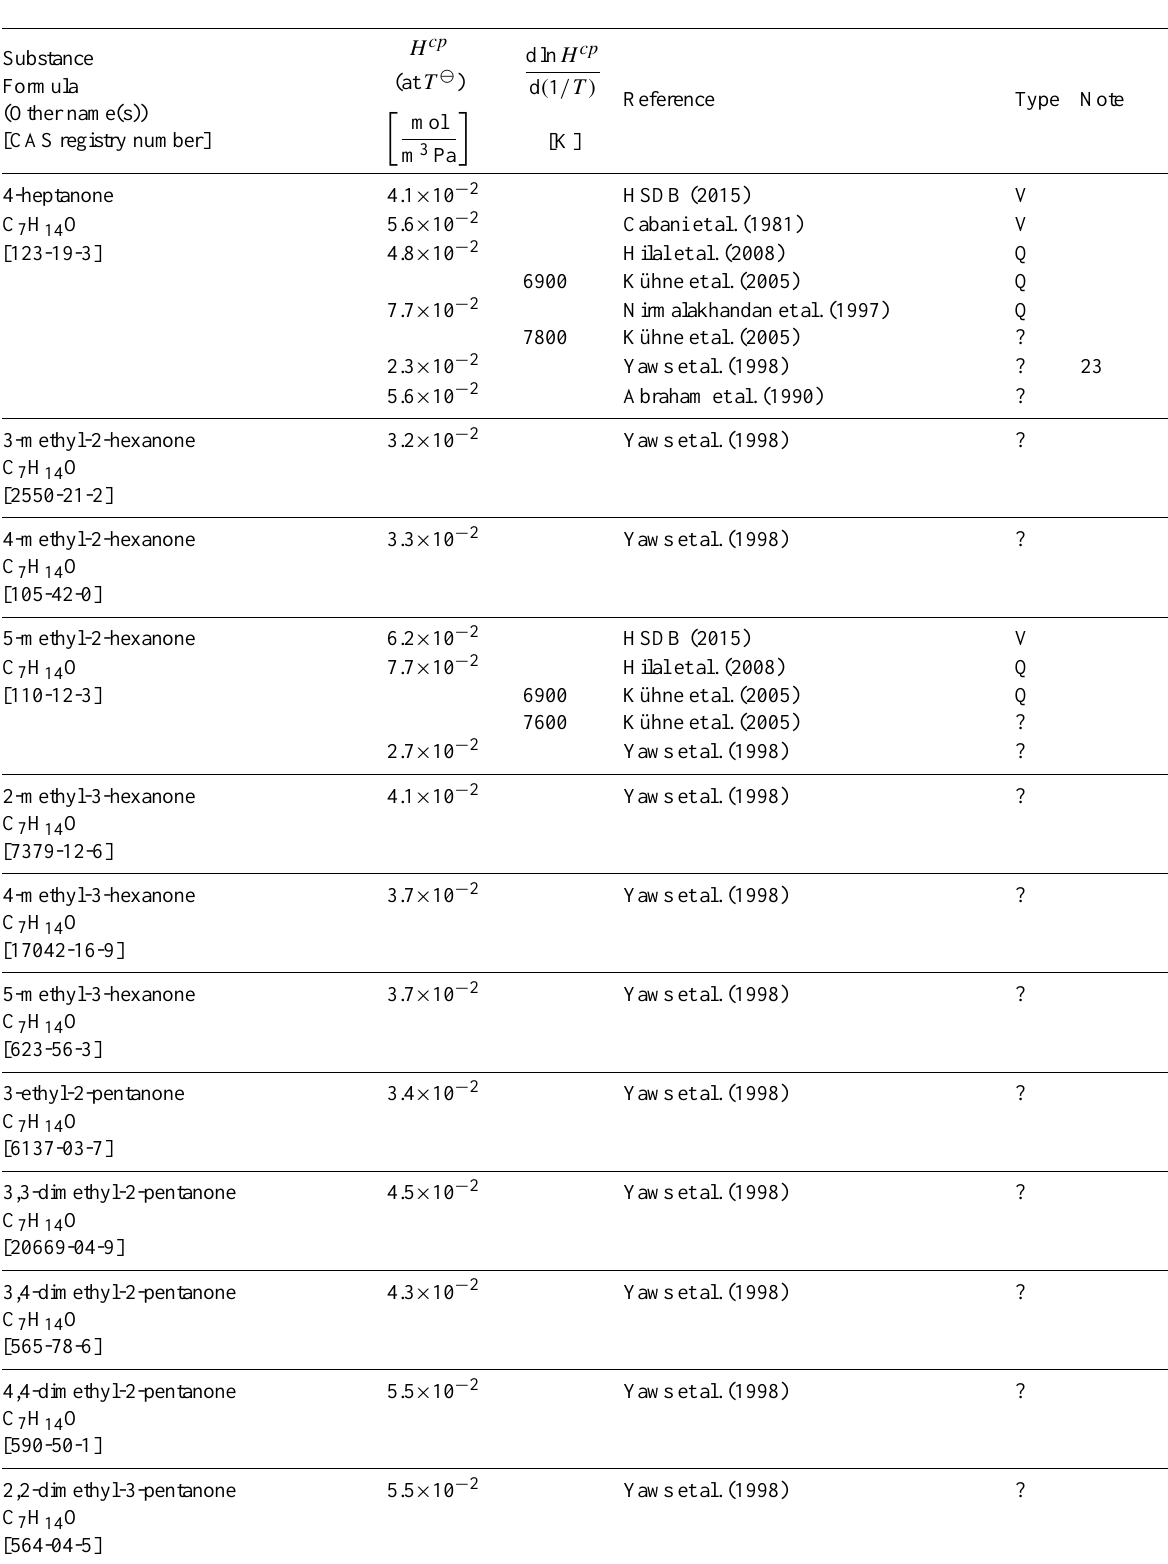
Table 6: Henry’s law constants for water as solvent